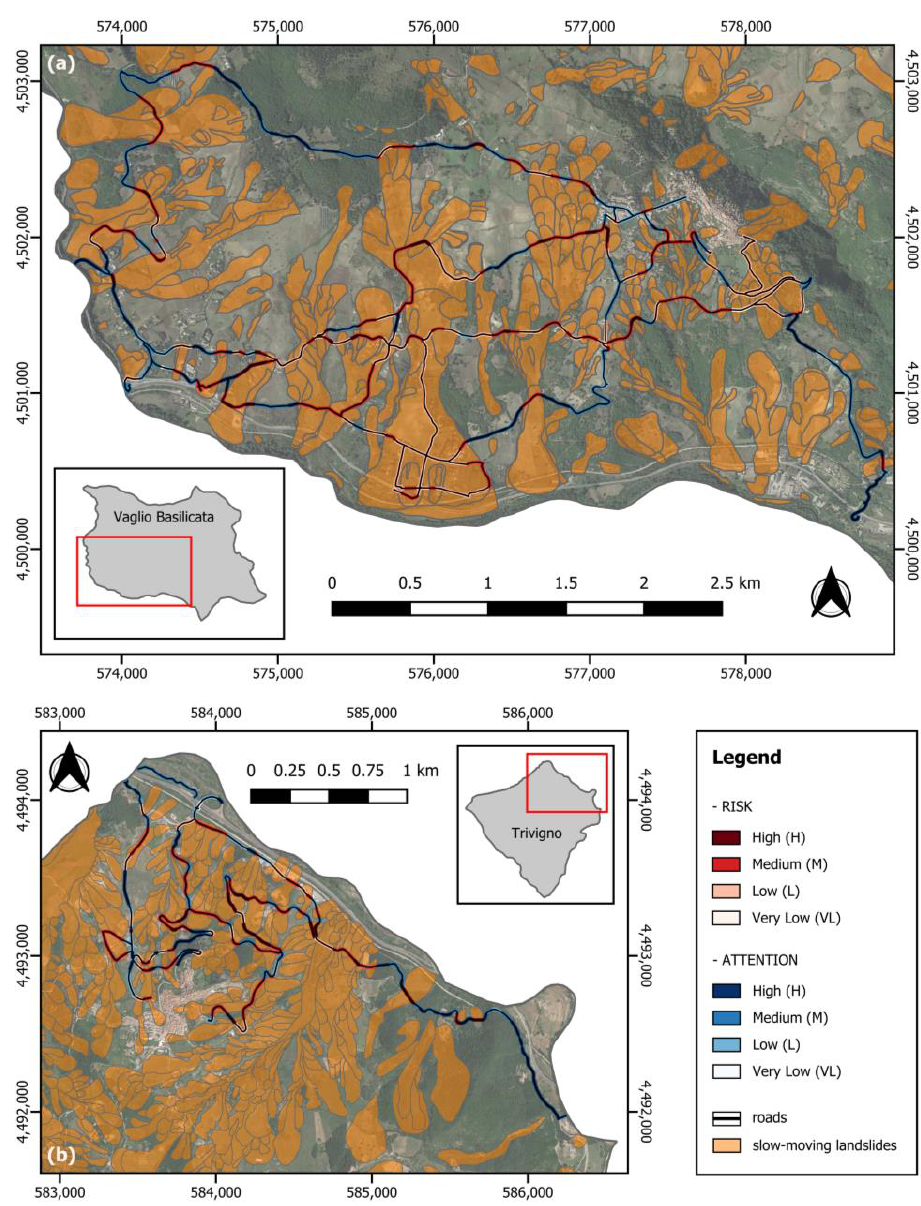
Figure 8. Classification of the investigated stretches of roads in different levels of risk and attention resulting from the application of the proposed methodology in two study areas of the municipalities of Vaglio Basilicata ( a ) and Trivigno ( b